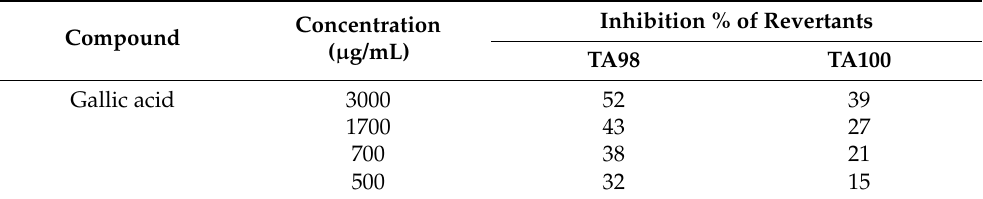
Table 3. Antimutagenic potential of gallic acid extracted from Ajwa date pits against S. typhimurium TA98 and TA100 bacterial